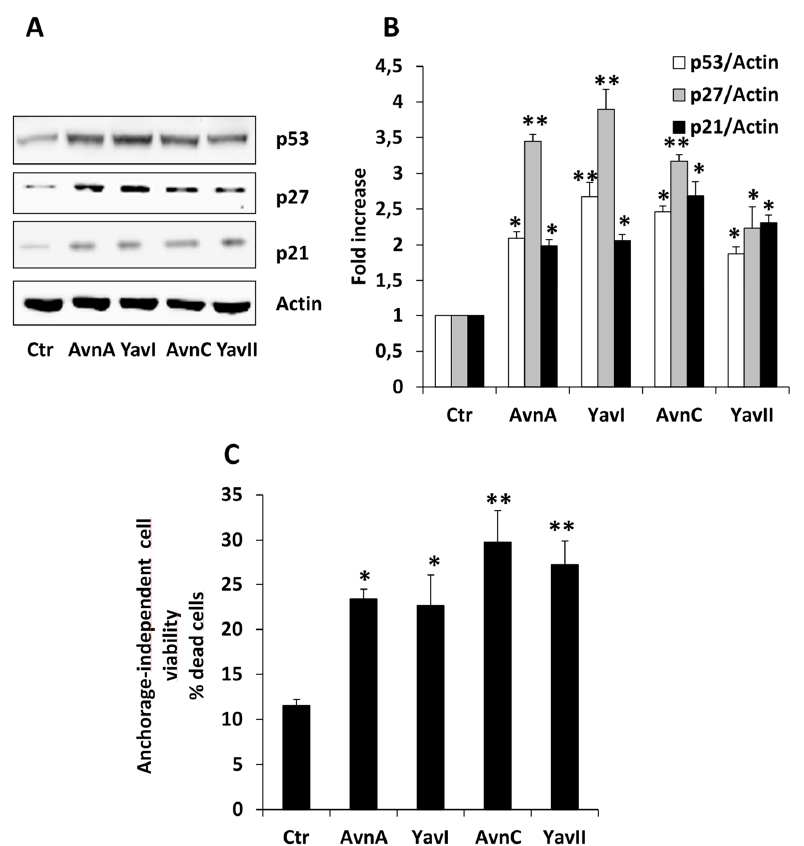
Figure 4. Induction of cell cycle blocking proteins and apoptosis by Avns and YAvns. ( A , B ) Representative images and quantification of western blot analysis of p53, p27 and p21 expression in HT29 cells treated with Avn-A, YAvnI. Avn-C and YAvnII (200 µM, 48 h). * p < 0.05 and ** p < 0.01 and vs. Ctr; ( C ) Cell vitality of HT29 in suspension treated with either Avn-A, YAvnI, Avn-C or YAvnII (200 µM, 48 h) in 0.1% of serum. Results are expressed as % of dead cells. * p < 0.05 and ** p < 0.01 vs. Ctr.